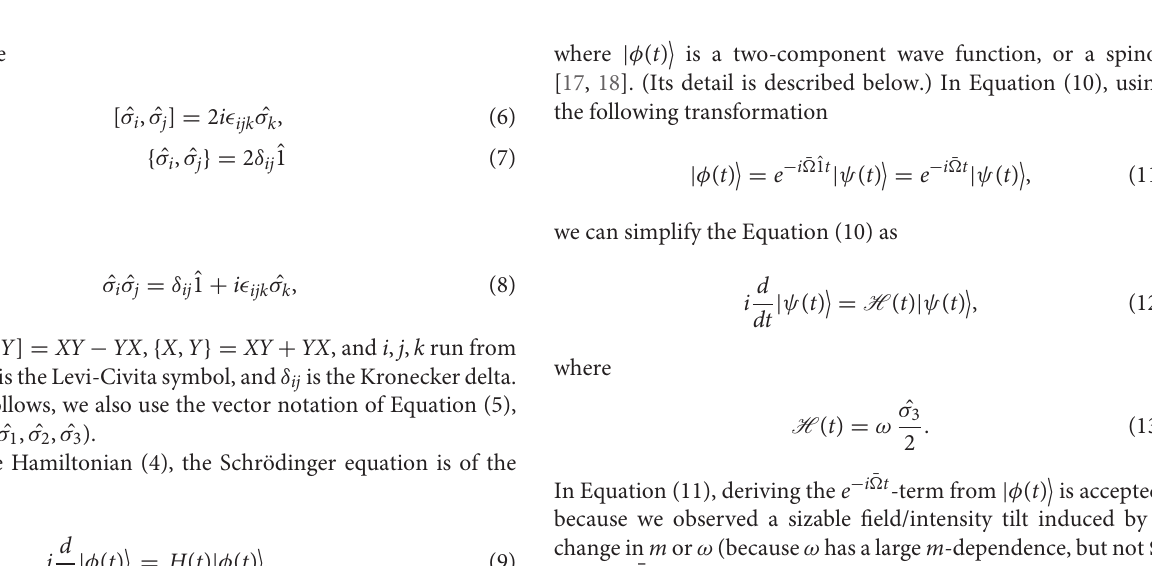
FIGURE 6 | Mode profiles of TE + 1 and TE − 1 at m / a 2 at k H z (B) Intensity 0.2925 2 π/ a of a crossing | | = ×